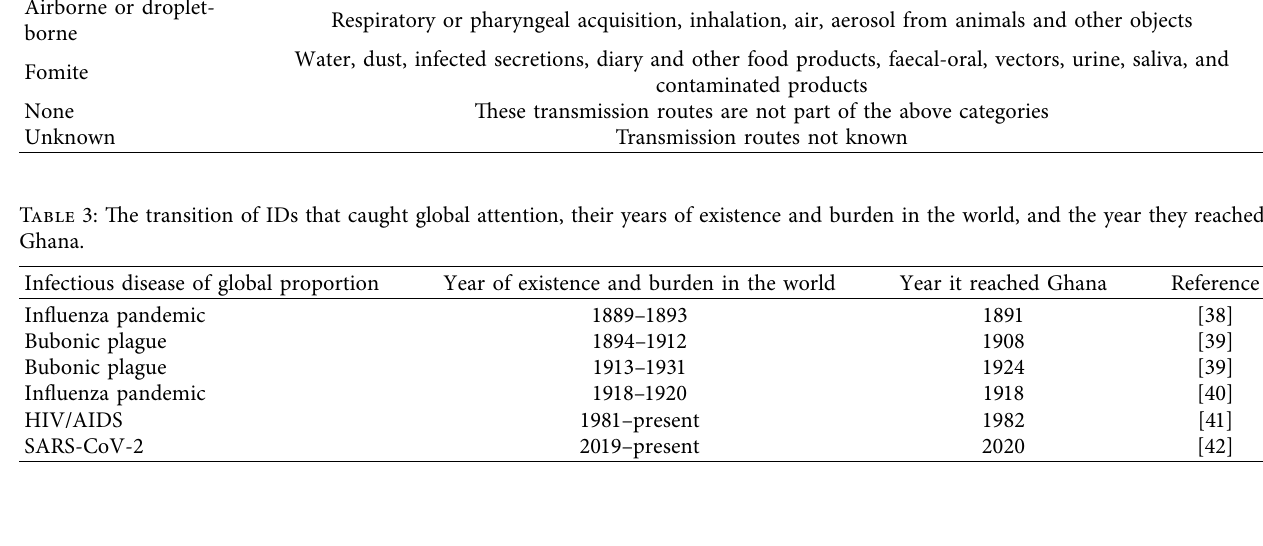
Table 4: The type of pathogens and reservoirs of infectious diseases in Ghana. The columns indicate the number in percentages of pathogens for each reservoir, and the rows indicate the number in percentages of reservoirs for each pathogen. Bacteria pathogens (column 2) hosted by humans (row 2) were the majority (number � 100 with 43.7%). Protozoa and fungi (rows 16 and 17) serving as reservoirs were represented to have the least pathogens (number � 3 with percentages of 66.7 and 33.3) they host,